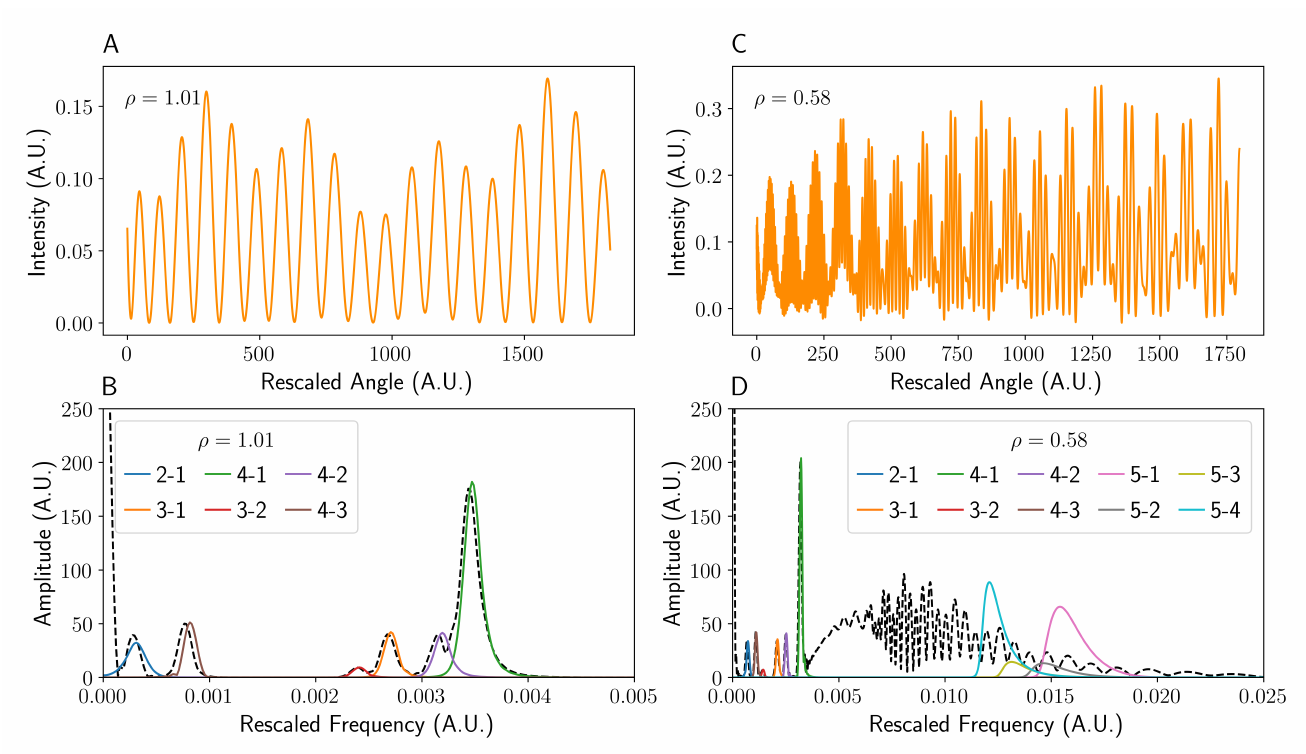
Figure 8. A series of graphs showing how dechirping of the interference pattern affects the Fourier domain. As can be seen in ( A , B ), the dechirping of the high ρ fringe pattern ( A ) leads to equally spaced fringes as well a Fourier transform that is the convolution of the pairwise interference terms ( B ). On the other hand, the dechirping of the low ρ intensity pattern ( C ) does not aid in the reconstruction of the beam 5 terms ( D ) due to its differing chirp frequency (see Figure 7). The black dashed line in ( B , D ) denotes the Fourier transform of the overall dechirped fringe patterns ( A , C ). For brevity, interference between beams i and j is denoted i − j . The data were windowed and zero-padded to reduce ringing and other artefacts after transformation, before finally